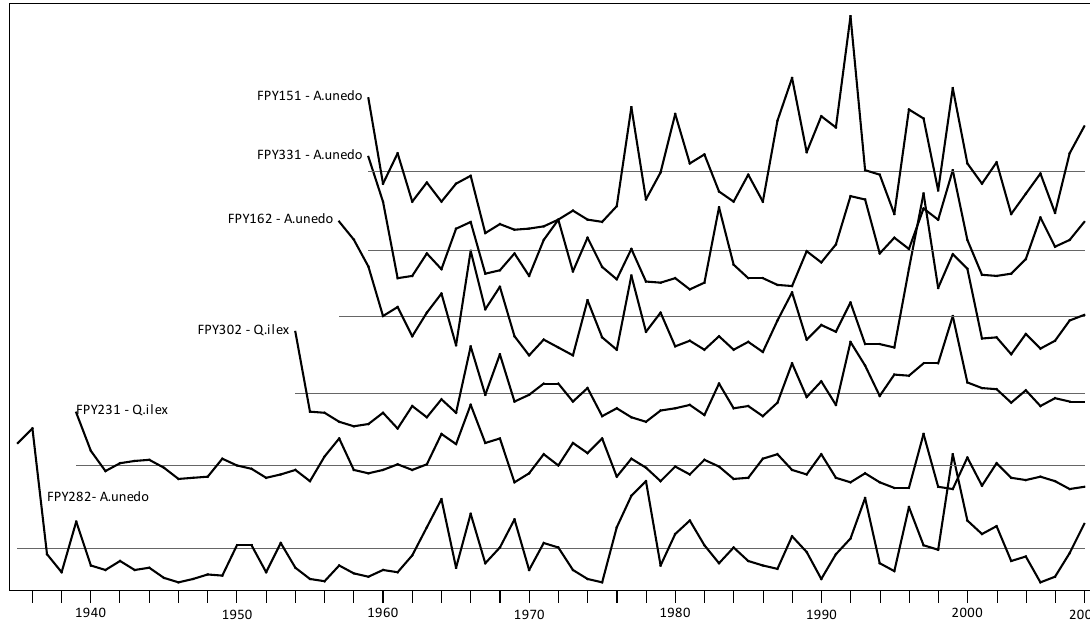
Fig. 4. Example ring-width series with characteristically large first rings reflecting coppice and resprouting growth of the forest. descriptive statistics. The correlation and sensitivity of the A.unedo chronology are higher than those of Q.ilex , indicat- ing a stronger common forcing on A.unedo . The substrate correlation for dolomite and the highest sensitivity for